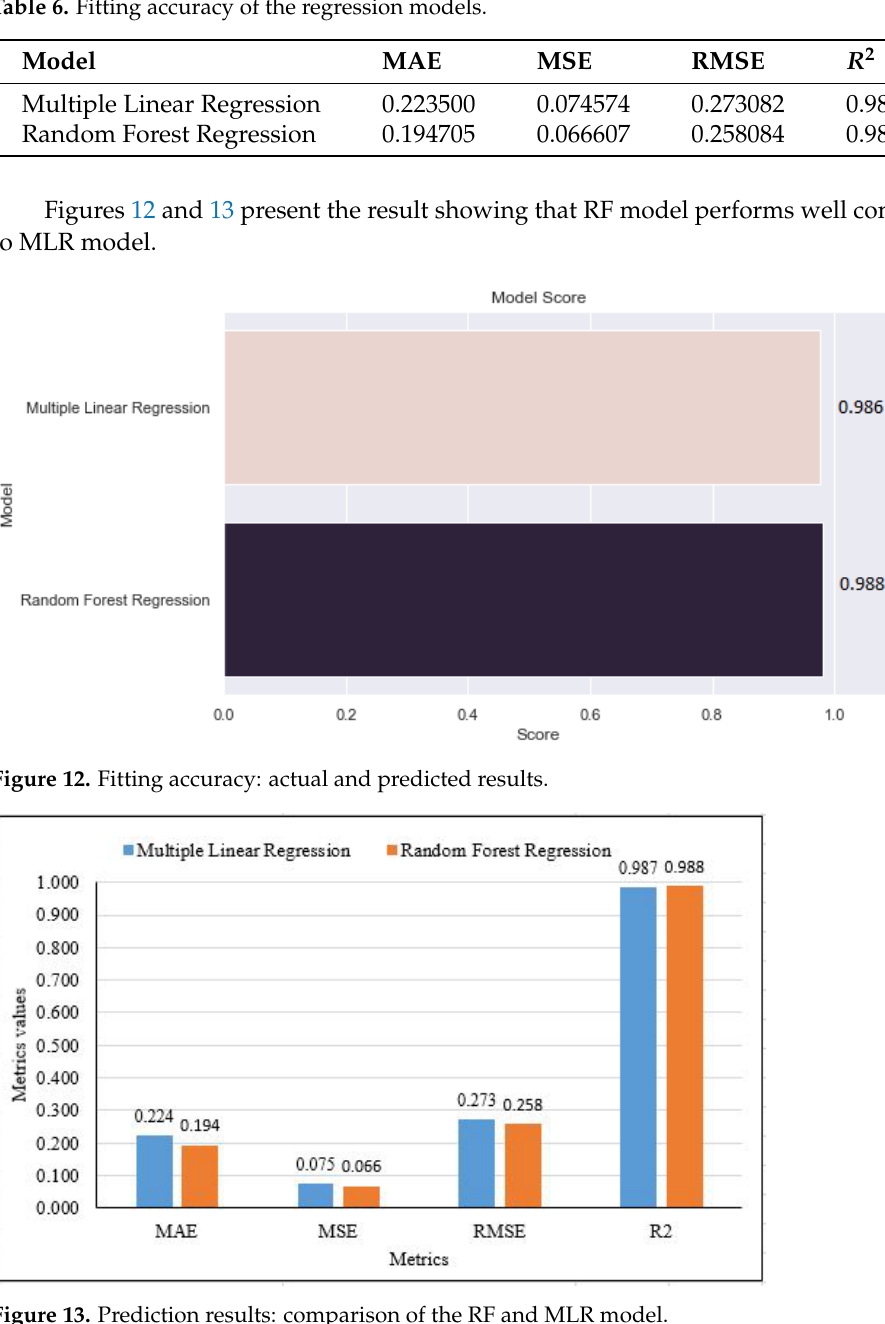
Figure 13. Prediction results: comparison of the RF and MLR